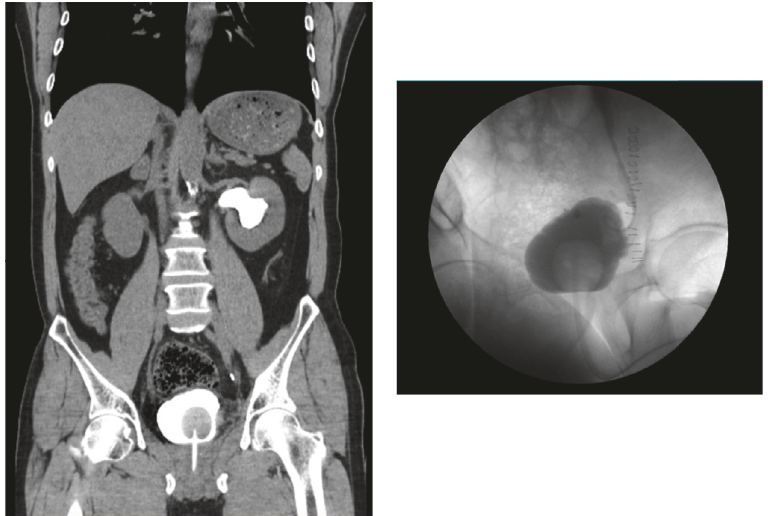
Figure 2: Computed tomography showing (a) abnormal elevation of the left ureterovesical area of the bladder with hydronephroureterosis and (b) degree of hydronephroureterosis with kinking ureter.